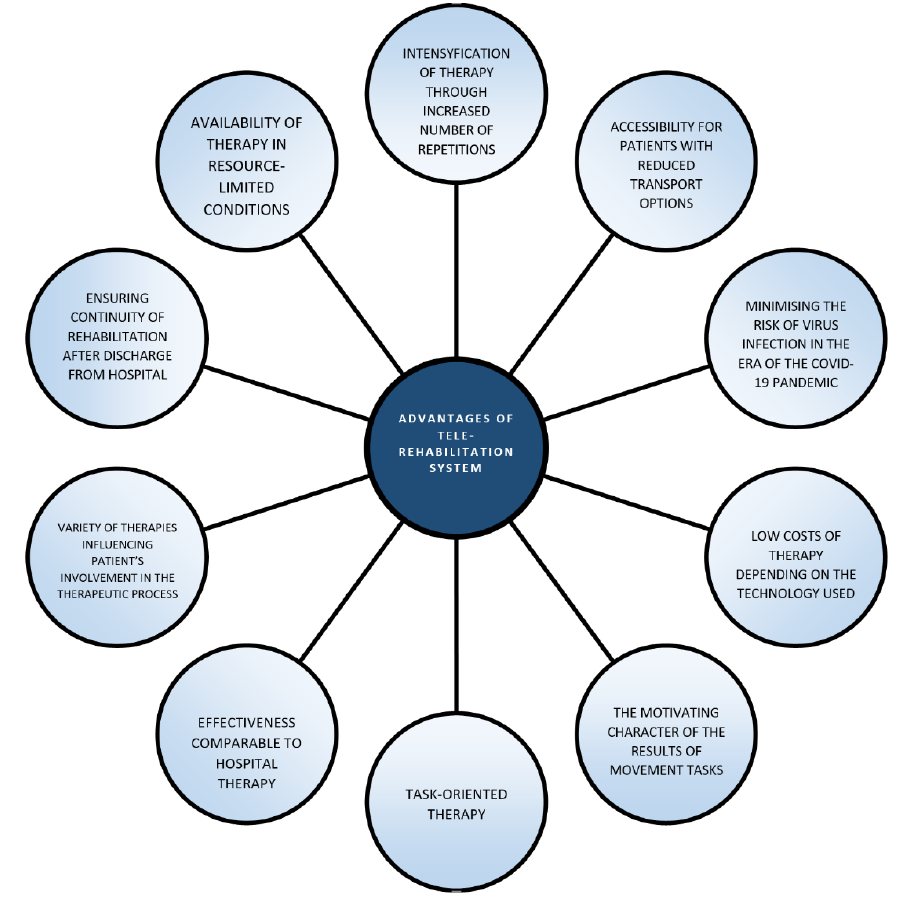
Figure 2. Advantages of telerehabilitation.